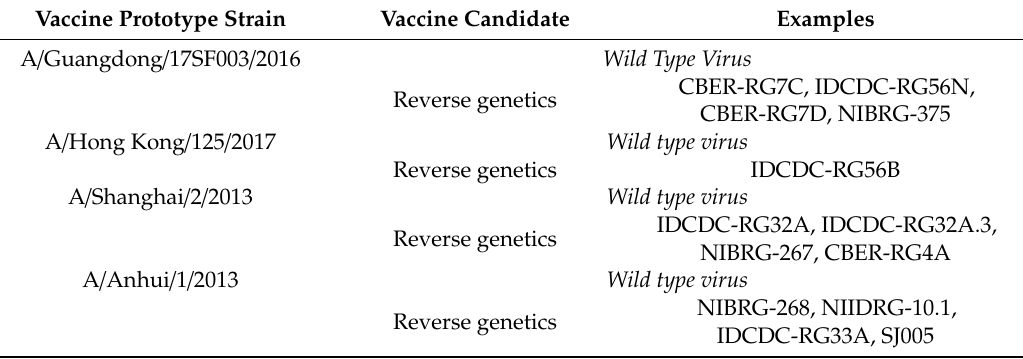
Table 1. WHO-recommended vaccine strains for H7N9 virus (adapted from